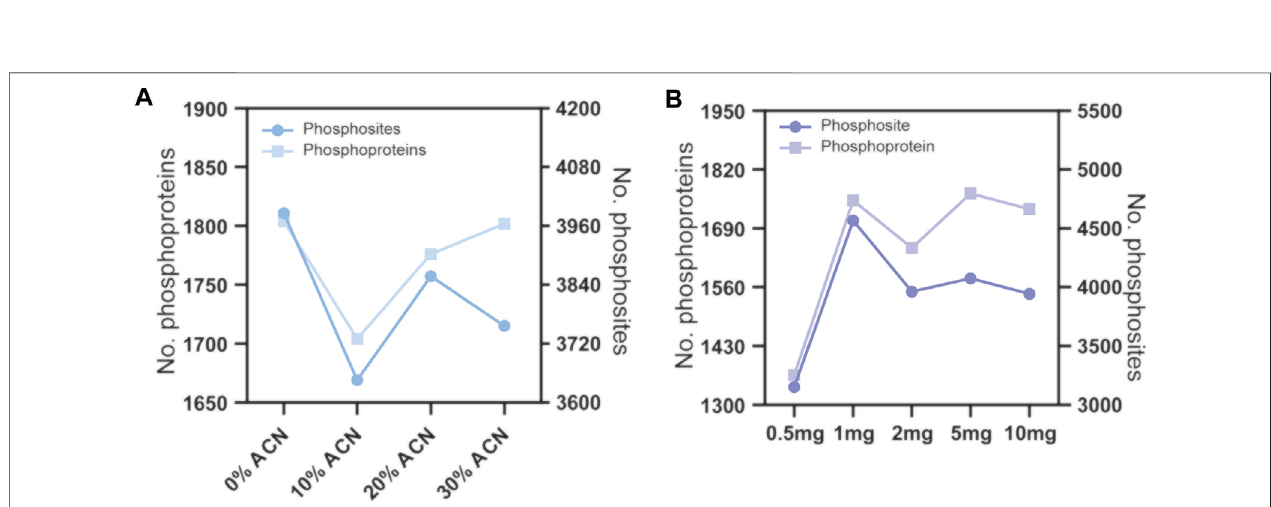
FIGURE 3 | Phosphopeptide enrichment from 160 μ g peptide samples using different conditions. (A) the ACN volume ratio of the eluting buffer were 0%, 10%, 20% and 30%. (B) the amount of TiO 2 microparticles were 0.5, 1, 2, 5 and 10 mg.